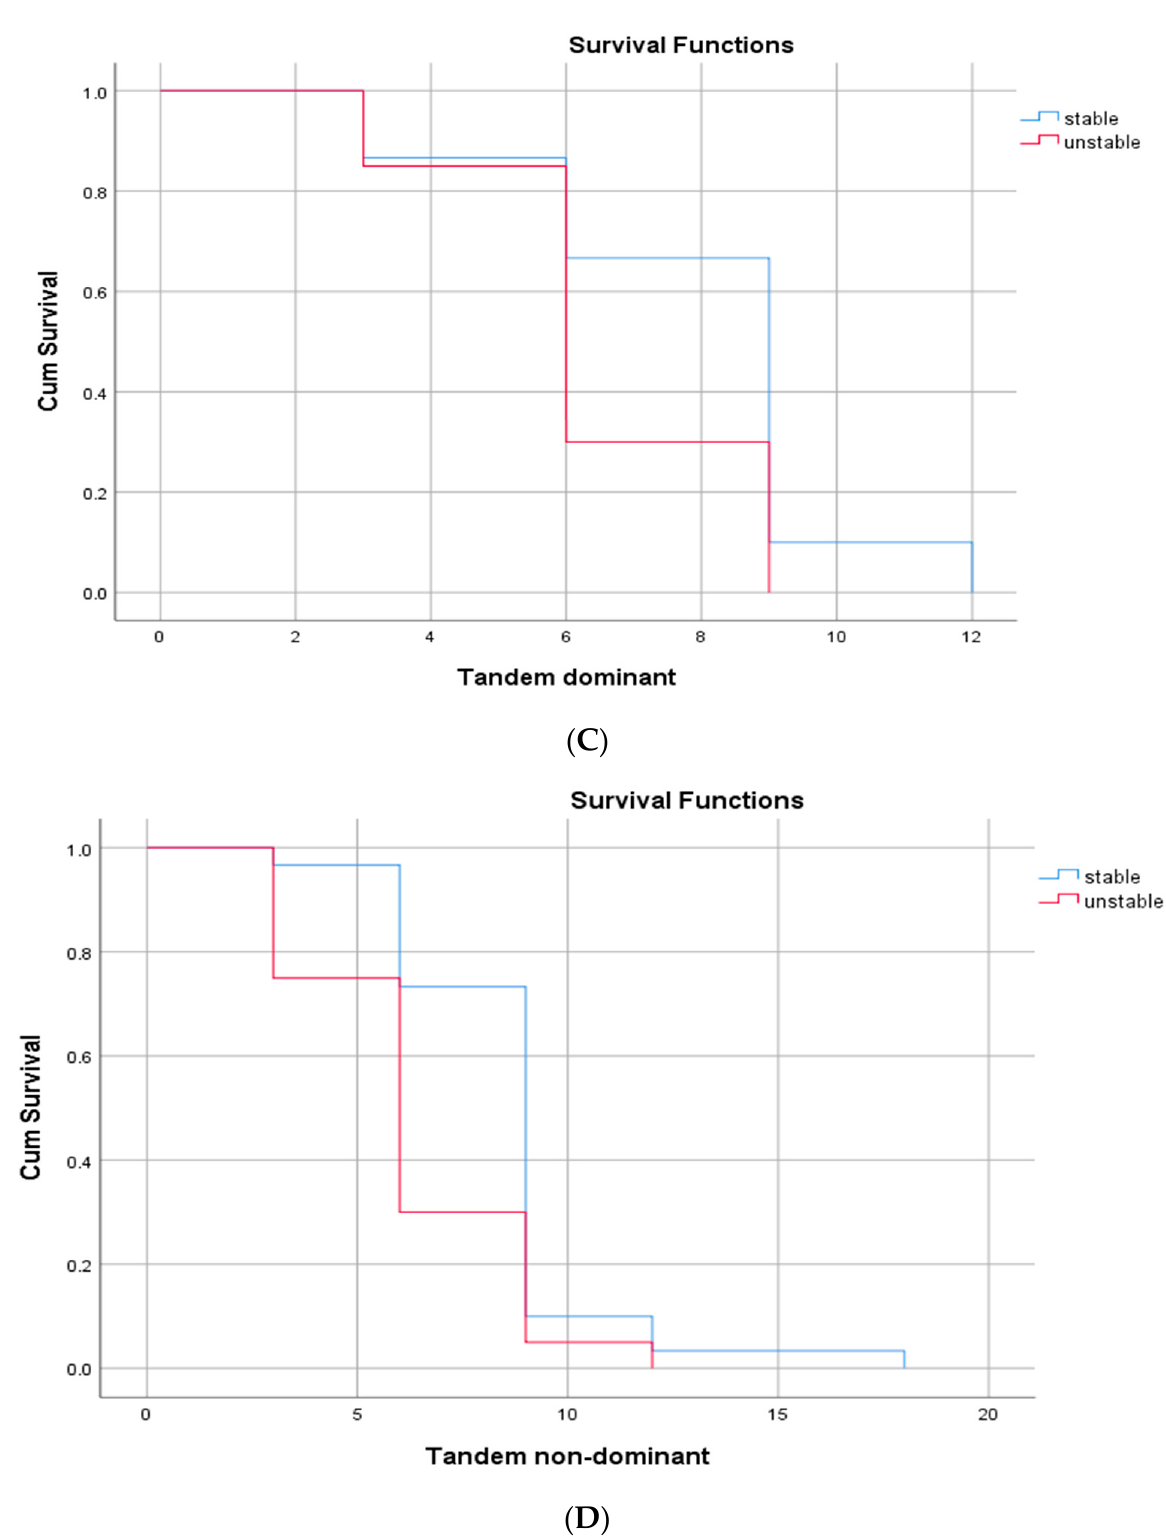
Figure 3. Survival curve for the level of losing postural balance in: ( A ) standing eyes open position ( B ) standing eyes closed position; ( C ) tandem-dominant leg forward; and ( D ) tandem non-dominant leg forward position] in individuals in the “stable” and “unstable” groups. Cum= cumulative. Table 4. Median ± SE for the level of losing postural balance in individuals in the “stable” and the “unstable” groups.